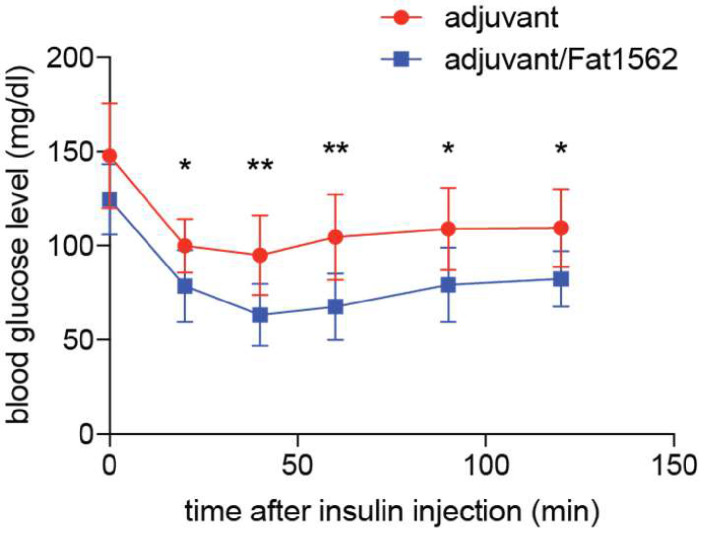
Absolute blood glucose levels.ITT analysis of mice transferred with vTreg53 TCR-tg Tregs and immunized with adjuvant/Fat1562 or adjuvant alone. Data shown are representative of at least two independent experiments (n ≥ 5).